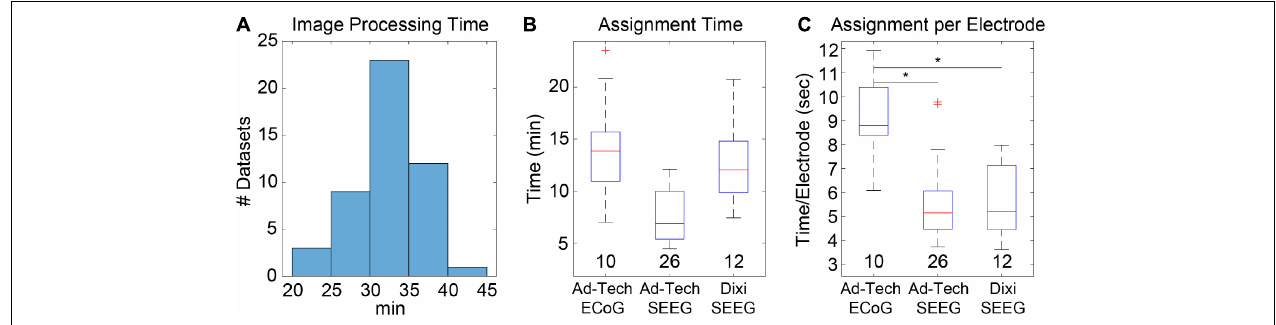
FIGURE 2 | Image processing and electrode assignment times for 48 datasets in LeGUI. (A) Histogram of image processing times per dataset. Total time includes image selection, rotation to ACPC space, coregistration of CT to MRI, segmentation of MRI, normalization to MNI space, and surface generation. (B) Electrode label assignment times grouped by vendor and electrode type. Each boxplot shows the median (red line), interquartile range (blue box), and extremes (whiskers). The number of datasets per group is shown below each boxplot. (C) Electrode label assignment times normalized by number of electrodes per dataset. ECoG electrodes take a significantly (pairwise rank-sum test, p < 0.01) longer time to assign a label than SEEG. Asterisks indicate significance.